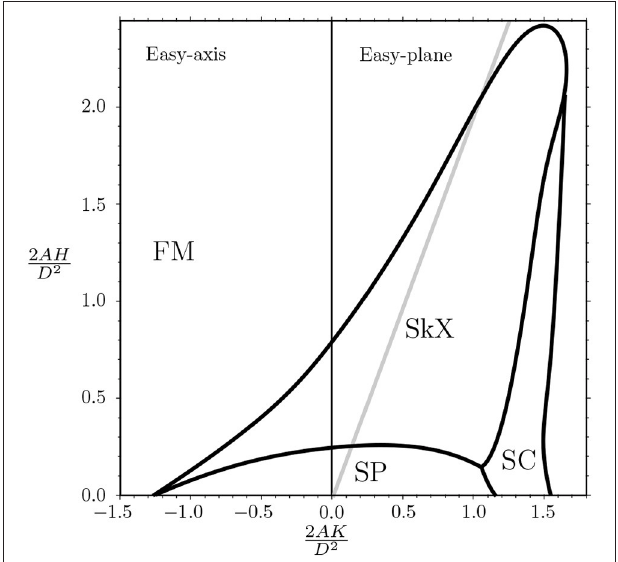
FIGURE 4 | Zero temperature phase diagram for the three cases corresponding to SO (3), C v , and D 2 d symmetries is obtained by numerically ∞ solving the LLG equation. The axes correspond to the dimensionless magnetic field and dimensionless uniaxial anisotropy parameter (see Equation 3). The gray line separates the aligned and the tilted regions of the FM phase. This phase is taken over by the hexagonal skyrmion lattcie (SkX), spiral (SP), and the square cell skyrmion lattice (SC) phases in the regions defined by the bold lines. Figure is adapted with permission from Güngördu et al.